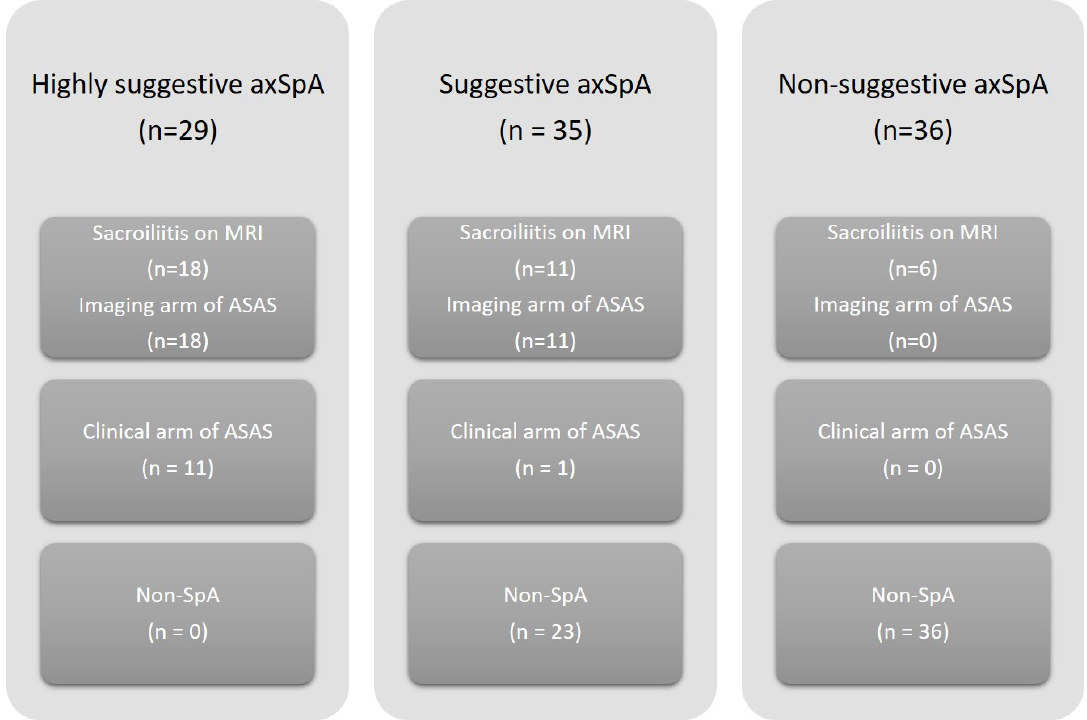
Figure 2. Distribution of patients with acute anterior uveitis according to present clinical SpA features and their classification according to ASAS classification criteria for axSpA. Highly suggestive of axSpA—if ≥ 4 SpA features were present regardless of HLA-B27 or if 2–3 SpA features were pre- sent together with HLA-B27. Suggestive of axSpA—if 2–3 SpA were present and HLA-B27 was ab- sent or 1 SpA feature was present together with HLA-B27. Nonsuggestive of axSpA—if 1 SpA fea- ture was present and HLA-B27 was absent or if patients did not experience chronic back pain. Ab- breviations: SpA, spondyloarthritis; AxSpA, axial spondyloarthritis; ASAS, Assessment of Spondy- loArthritis International Society Classification criteria for axSpA. 3.6. Follow-Up Examination after Two Years Of the 67 patients with AAU and baseline MRI without highly suggestive BME, 55 patients participated in a follow-up examination after 2 years. Twelve patients did not attend this visit, mostly due to the COVID-19 pandemic. Fifty-three patients with AAU remained MRI negative (and did not fulfil the ASAS classification criteria) and two pa- tients with chronic low back pain developed active MRI sacroiliitis. Both patients were HLA-B27 positive, the character of chronic back pain changed to inflammatory, and one patient had significantly elevated CRP levels (28.3 mg/L) on the second laboratory exam- ination; thus, both were newly classified as axSpA. 4. Discussion This is the largest study evaluating MRI of SIJ, fulfilment of the ASAS classification criteria for SpA (regardless of patient’s age), and expert clinical diagnosis of SpA in pa- tients with AAU, including rheumatologic follow-up after two years. MRI-defined sacro- iliitis (highly suggestive BME) was found in 36% of AAU patients. However, six patients were not diagnosed with axSpA due to the absence of chronic low back pain. All patients classified as highly suggestive axSpA fulfilled the ASAS classification criteria (18 fulfilled the imaging arm and 11 fulfilled the clinical arm). Follow-up examination after two years in 55 initially MRI-negative patients revealed two patients who developed axSpA with active sacroiliitis. These findings raise the question of whether all patients with AAU should undergo a targeted rheumatological examination to rule out SpA.